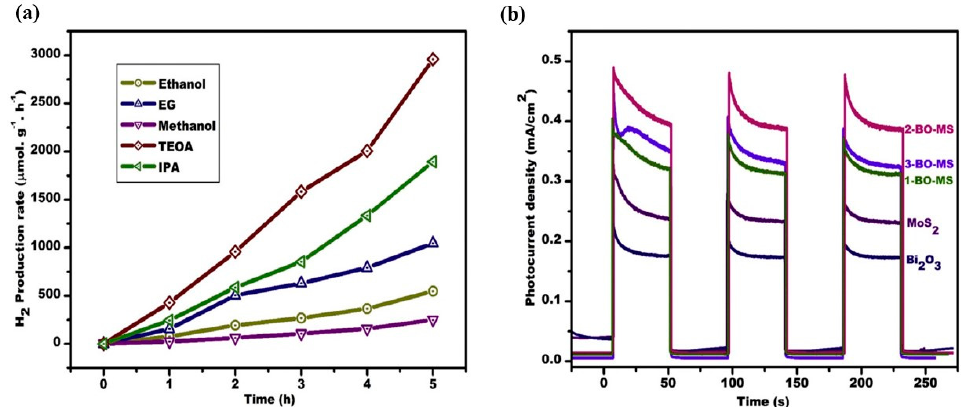
Figure 10. ( a ) Photocatalytic H 2 evolution rate over various scavengers, ( b ) Photocurrent response of the MoS 2 , Bi 2 O 3 , 1-BO-MS, 2-BO-MS, and 3-BO-MS catalysts under visible light. [Reprinted with permission from reference [134]. Copyright 2021, Elsevier].